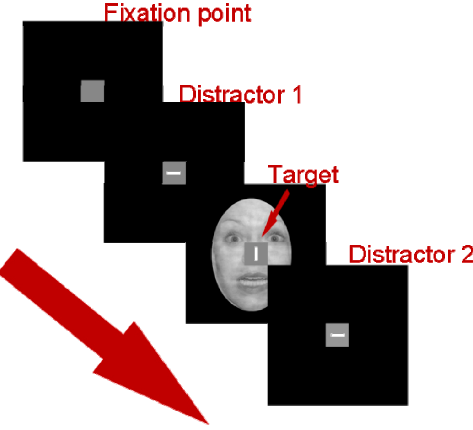
Figure 1. The modified flanker task. This example is of a fearful face incongruent trial.